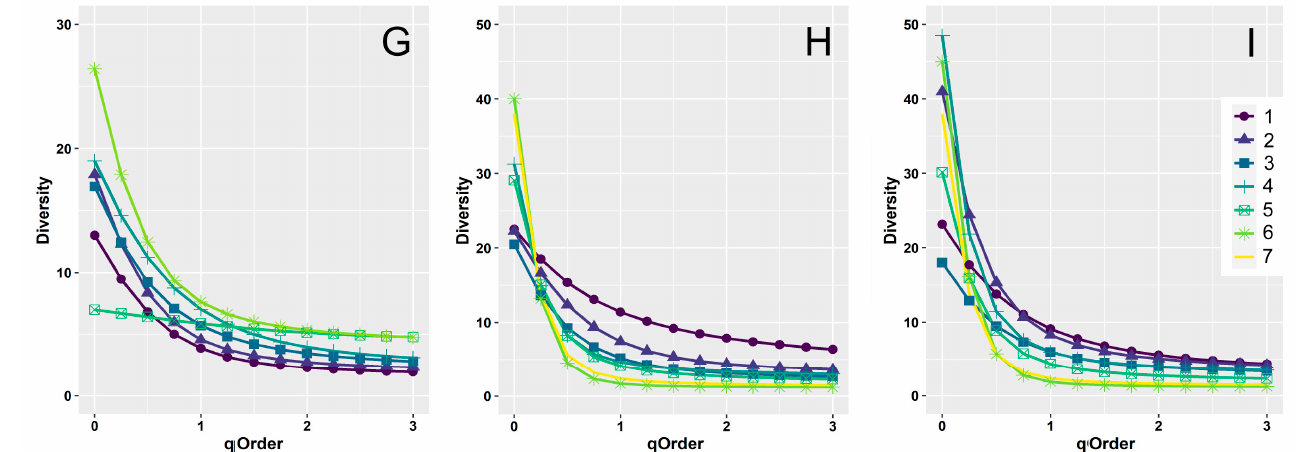
Figure 1. Diversity curves using Hill numbers for dung beetle assemblages along an elevational gradient in central Italy. Curves were constructed using empirical ( A – C ), rarefied/extrapolated ( D – F ), and asymptotic ( G – I ) values for the two habitats (woodlands and grasslands) separately (woodlands: A , D , G ; grasslands: B , E , H ) and merged ( C , F , I ). Dung beetles were sampled in seven altitudinal intervals (belts) of 150 m extent: Belt 1: 950–1100 m, Belt 2: 1100–1250 m, Belt 3: 1250–1400 m, Belt 4: 1400–1550, Belt 5: 1550–1700, Belt 6: 1700–1850, Belt 7: 1850–2000. For ease of reading, 95% confidence intervals are not shown here, but they are reported in Figure S1.